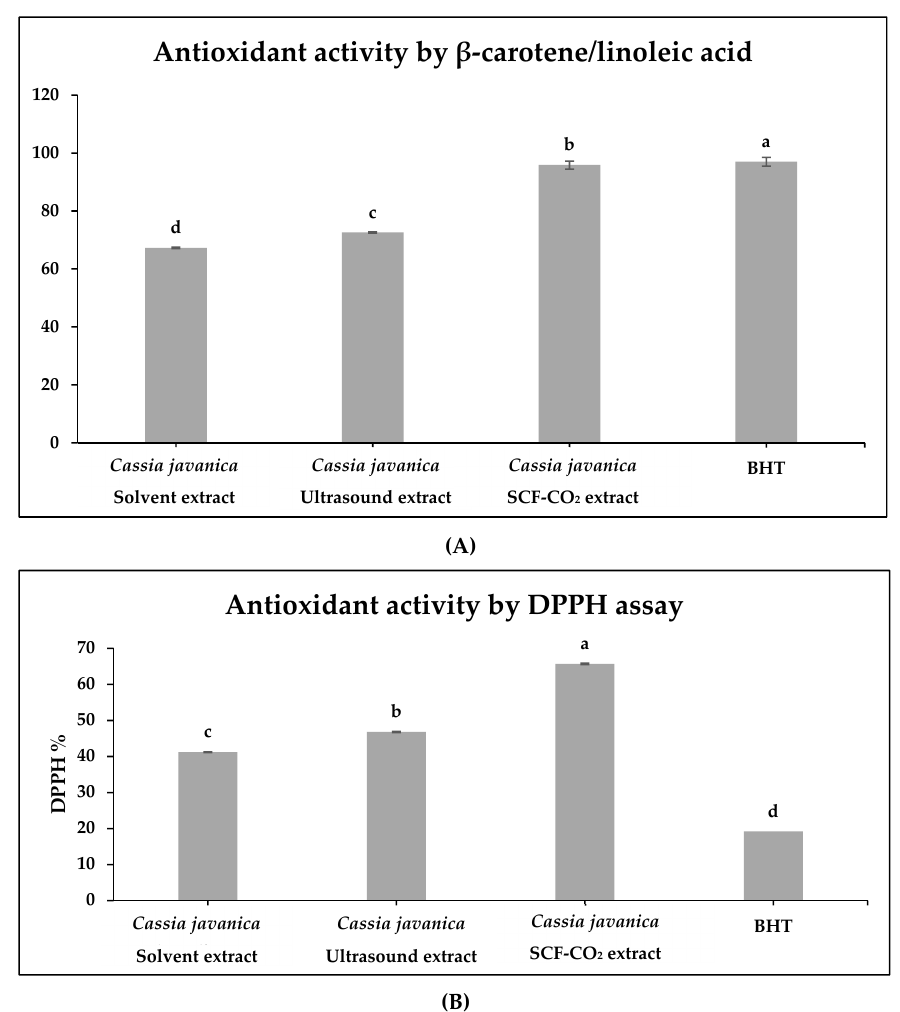
Figure 5. Antioxidant activity by ( A ) β -carotene/linoleic acid assay (inhibition ratio %); ( B ) DPPH assay of CJDP treated samples. BHT was used as a positive control. a –d different superscripts in a column were significantly different ( p < 0.05); data are means ± S.D. ( n = 3).